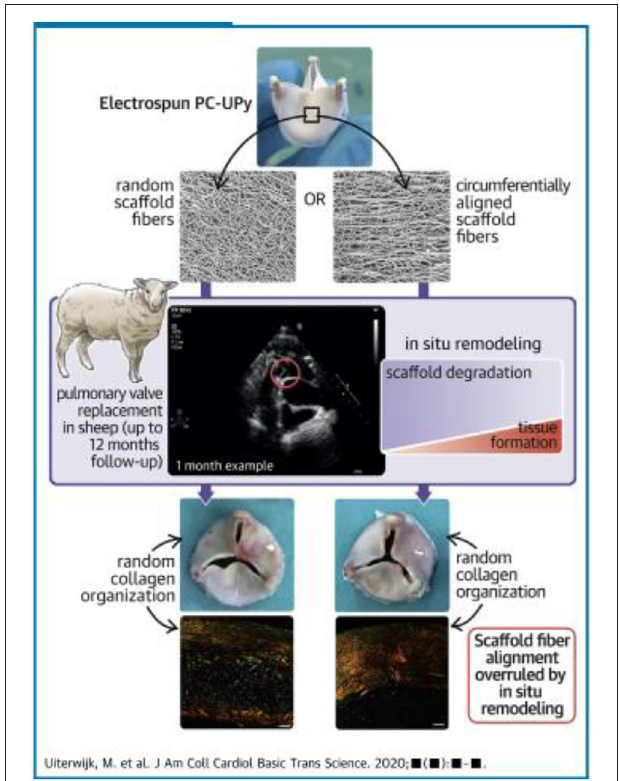
FIGURE 11 | Concept of in situ tissue engineering heart valves: electrospun tri-leaflet valve scaffolds of ureidopyrimidinone-polycarbonate with either a random fiber alignment (rTEHV) or with fibers with a predominant alignment in the circumferential direction of the valve leaflet (aTEHV). Electrospun tubular conduits are sutured onto a crown-shaped polyether ether ketone supporting ring (outer diameter 20mm, inner diameter 18mm) to create a tri-leaflet valvular shape. The scaffold microstructure is analyzed via scanning electron microscopy (SEM), and fiber alignment is quantified. In vitro valve functionality is evaluated in a hydrodynamic pulsatile duplicator system under physiological pulmonary conditions and sterilized by gamma irradiation. Subsequently, surgical orthotopic pulmonary valve replacement is performed in female Swifter sheep